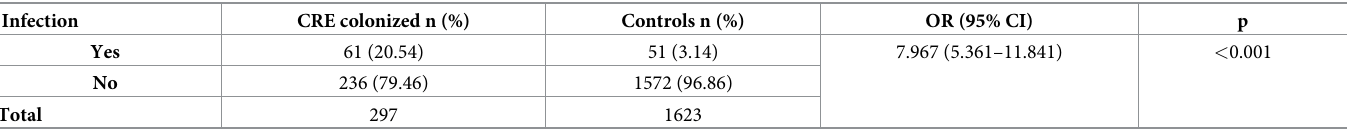
Table 1. Univariate analysis of the risk of development of invasive clinical CRE infection in the sample.